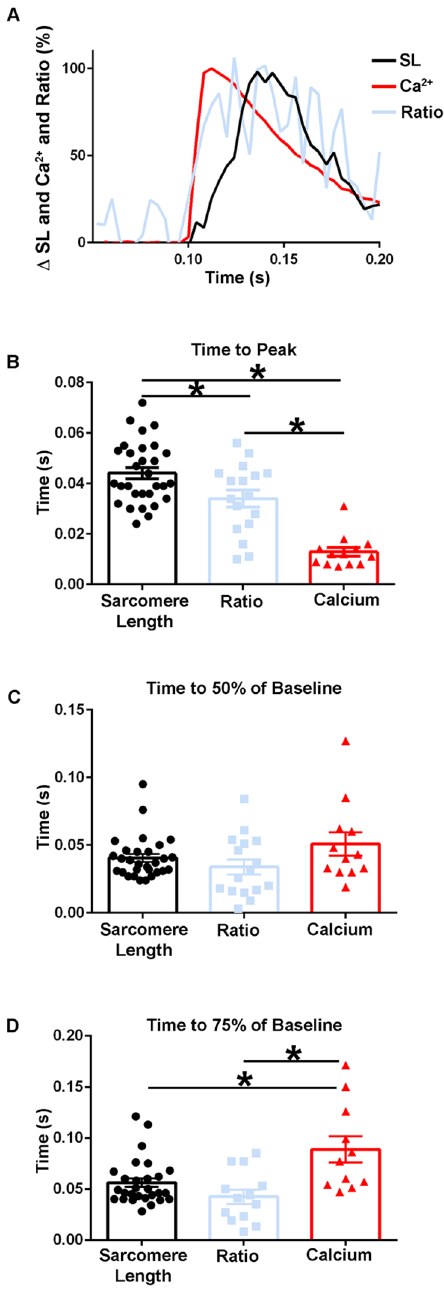
Figure 9. Temporal alignment of sarcomere length, TnC biosensor transient, and calcium transient kinetics during a twitch at room temperature. ( A ) Normalized traces (0–100%) of an ensemble average of FURA-2 calcium fluorescence (red), biosensor ratio fluorescence (blue), and sarcomere length (black) dynamics. This figure is a graphic compilation of data shown in Figs. 6 and 8. ( B ) Summary statistics of the time to peak amplitude for sarcomere length, biosensor transient, and calcium transient shows the time to peak of the biosensor significantly precedes that of the sarcomere length, and the time to peak of calcium is reached before both the biosensor transient and sarcomere length (Sarcomere length: n = 30 myofibers from n = 14 animals, Ratio: n = 17 myofibers from n = 11 animals, FURA-2: n = 13 myofibers from n = 3 animals). ( C ) Summary statistics of the time to 50% of baseline for sarcomere length, biosensor ratio transient, and the calcium transient (Sarcomere length: n = 29 myofibers from n = 14 animals, Ratio: n = 16 myofibers from n = 11 animals, FURA- 2: n = 12 myofibers from n = 3 animals). ( D ) Summary statistics for the time to 75% of baseline for sarcomere length, biosensor ratio transient, and calcium transient shows the calcium decay transient is significantly slower than both the relaxation of sarcomere length and the biosensor transient inactivation. (Sarcomere length: n = 29 myofibers from n = 14 animals, Ratio: n = 16 myofibers from n = 11 animals, FURA-2: n = 12 myofibers from n = 3 animals). Myofibers measured at room temperature with 0.2 Hz stimulation. Mean ± S.E.M. are presented, * P <